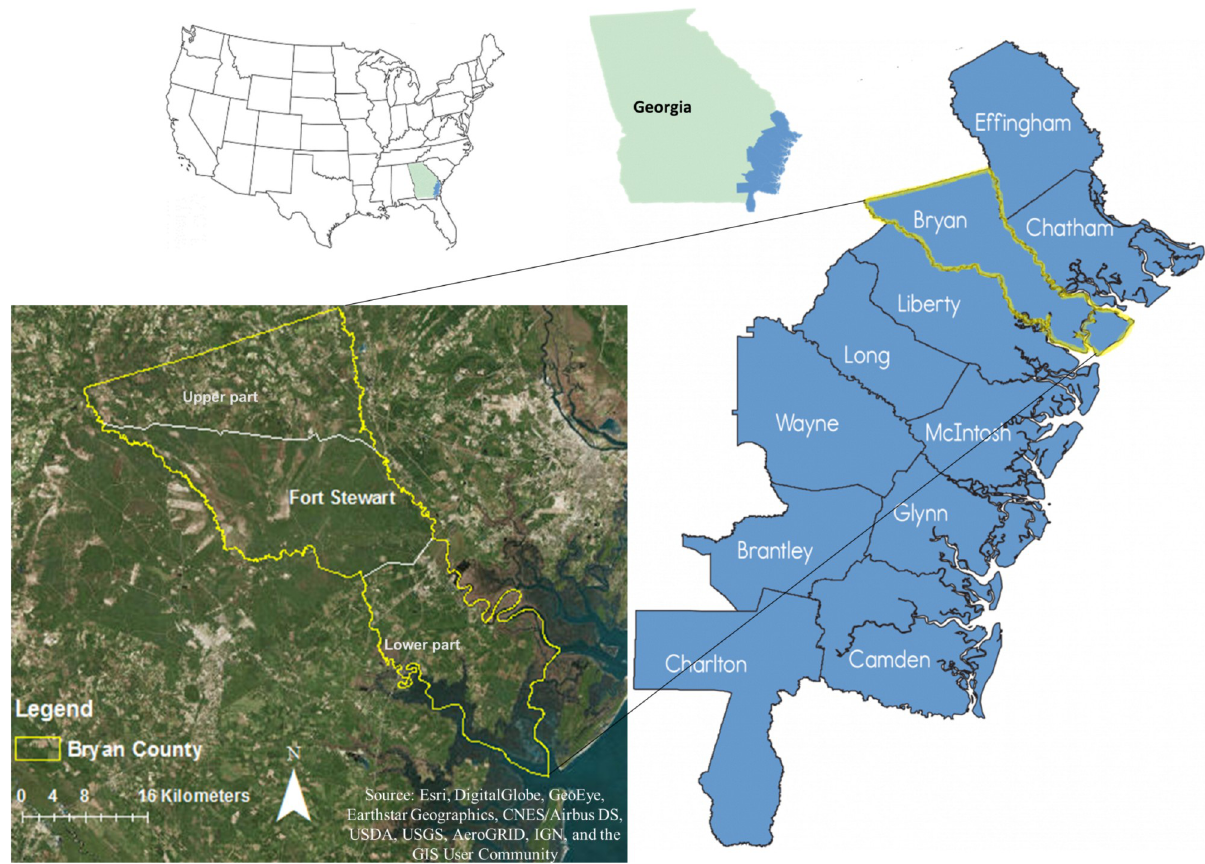
Fig 1. The study area is in the Coastal Plain of Georgia located at the southern part of Bryan County, Georgia, USA. Adopted and modified from Georgia Department of Natural Resources, Coastal Resources Division [32,